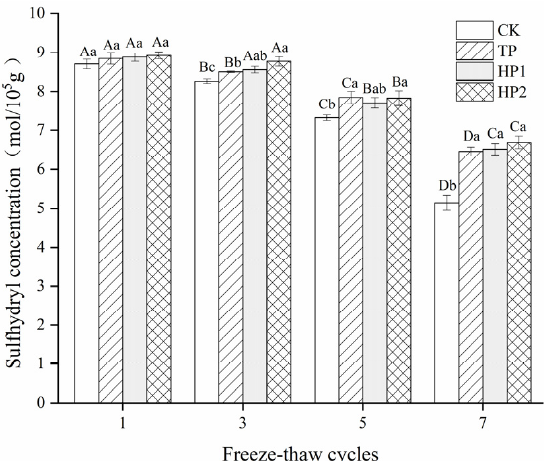
Figure 3. Changes in sulfhydryl contents of freeze-thawed fish fillets: CK: fillets in distilled water; TP: fillets in tea polyphenol; HP1: fillets in 1% bone hydrolysates; HP2: fillets in 2% bone hydrolysates. Different capital letters indicate the results that differ significantly in freeze–thaw cycles with the same treatment ( p < 0.05). Different lowercase letters indicate the results that differ significantly with different treatments in the same freeze–thaw cycle ( p < 0.05).